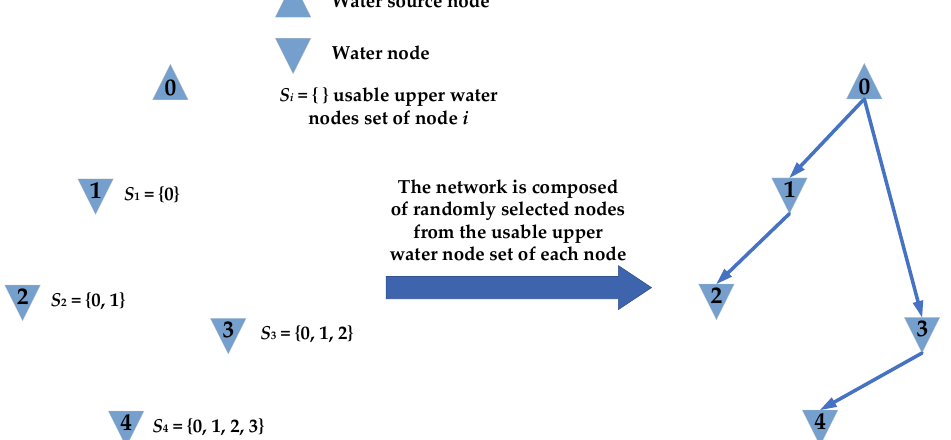
Figure 1. Schematic diagram of the calculation process of the improved pipe network planning model.